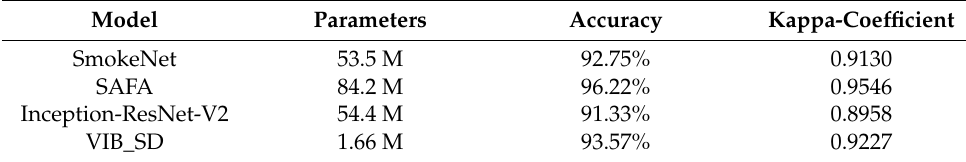
Table 5. Model performance comparison.